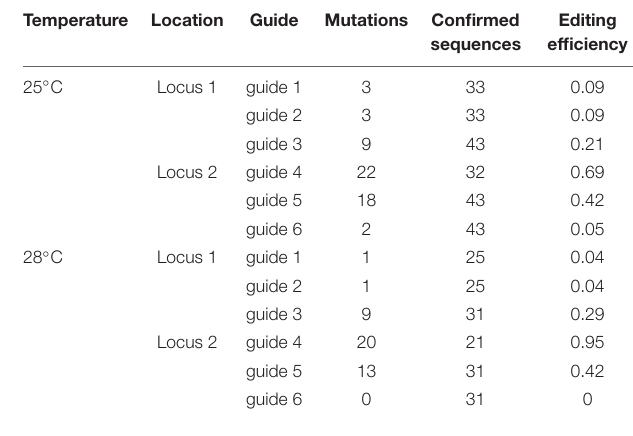
TABLE 2 | Mutations in T 0 wheat lines targeting DNA sequences downstream of locus 1 (TraesCS7A02G014100) and locus 2 (TraesCS7A02G146100) at each guide location when grown under two different temperature